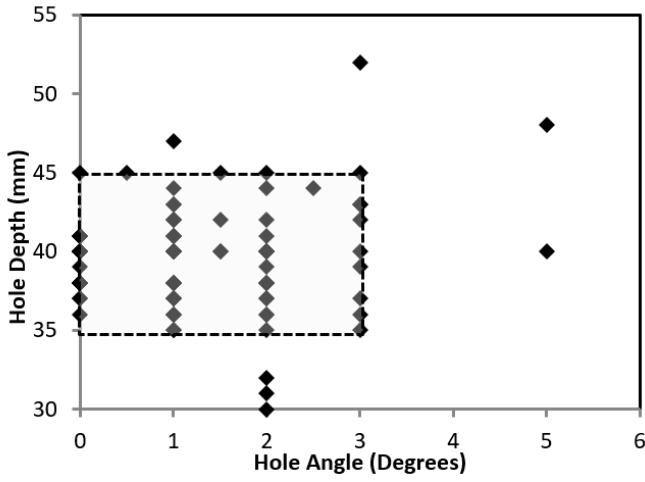
Figure 15. Depth of hole vs. angle from vertical.